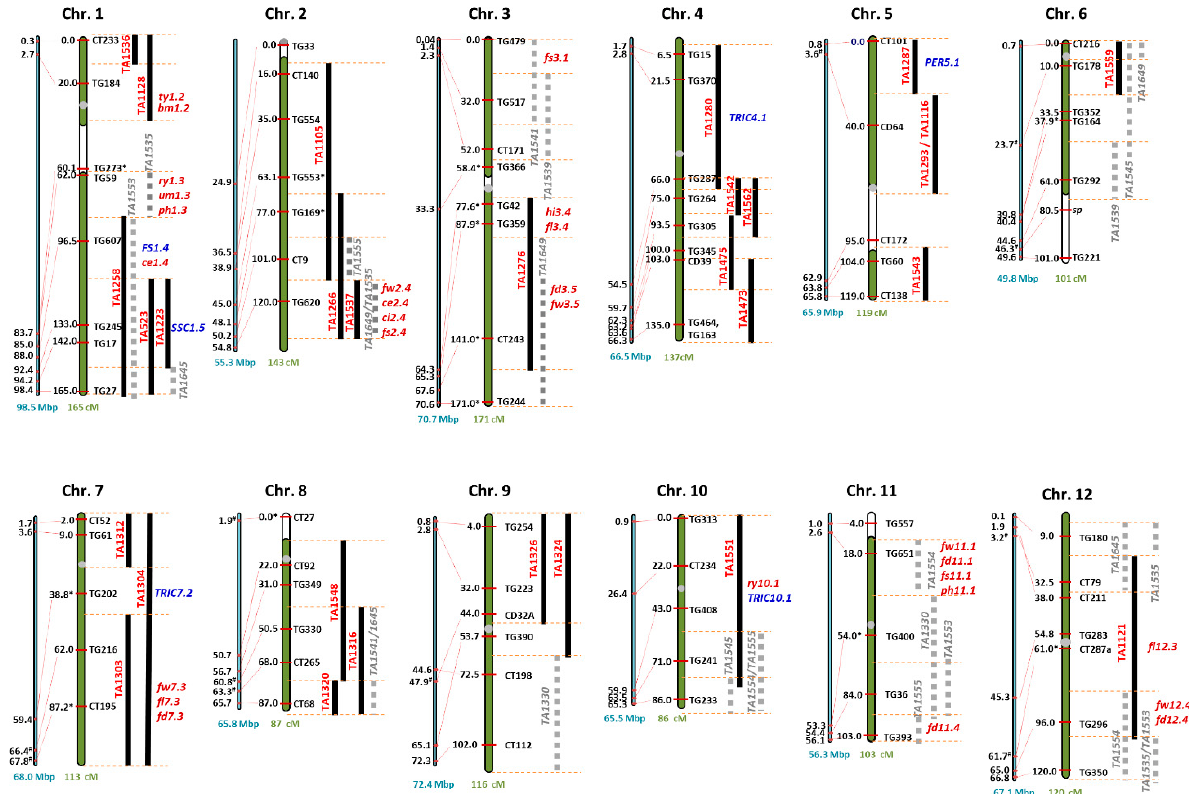
Figure 4. Genetic map showing the position of the markers delimiting the ILs and used for the quantitative trait loci (QTL) analysis. Markers are indicated on the right side of each chromosome, whereas map distances in centiMorgan (cM) are indicated on the left side and are based on the Tomato-EXPEN 2000 and Tomato-EXPEN 1992 (with asterisks) mapping populations [32]. At the bottom of each chromosome, the total genetic length is mentioned. Black bars indicated ILs carrying a single homozygous introgression. Dashed lines indicate ILs with multiple introgressions. The empty part of each chromosome indicates the regions not covered by wild introgressions. Centromeres are indicated with gray dots. Light blue bars on the left of each chromosome indicate the genomic positions of the markers based on tomato reference annotation SL4.0. The total length in megabases is reported at the bottom. Only robust QTLs detected across the three consecutive seasons are reported. The QTLs are in italics and defined by the trait abbreviation, followed by the chromosomal BIN (region delimiting single or overlapping introgressions). In uppercase and blue font are the QTLs increasing the trait performances. In red and in lowercase are the indicated QTLs decreasing the